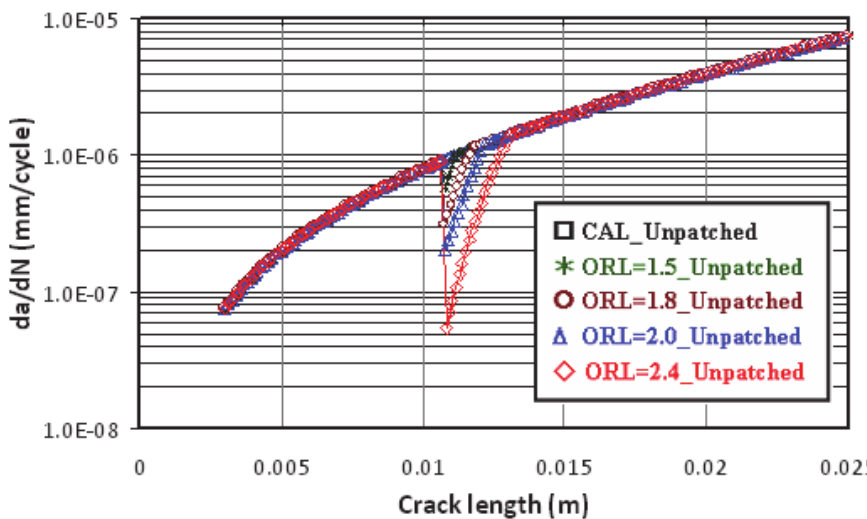
Figure 4: Overload ratio effect on fatigue crack growth rate for unpatched 2024 T351